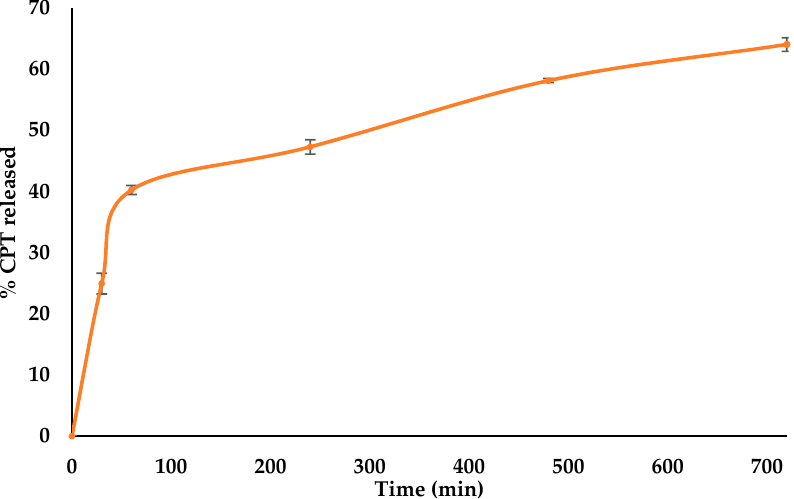
Figure 2. Dissolution profile ( n = 6) of optimised HCTZ microparticles.